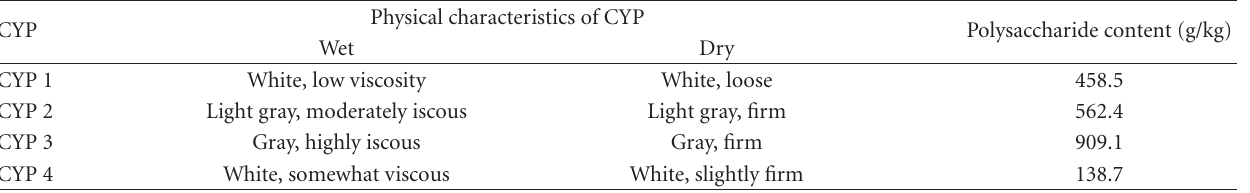
Table 2: Physical characteristics and net content of the four fractions of Chinese Yam polysaccharide (CYP).